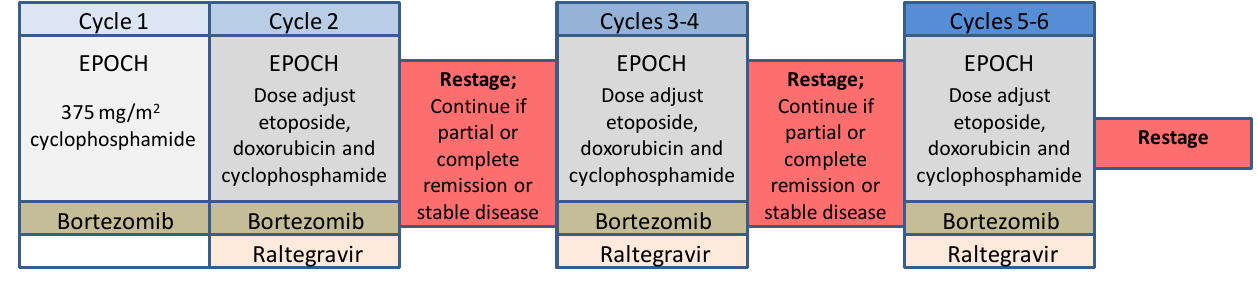
Figure 4. Schema for an ATLL clinical trial using NFκB targeted therapy. The